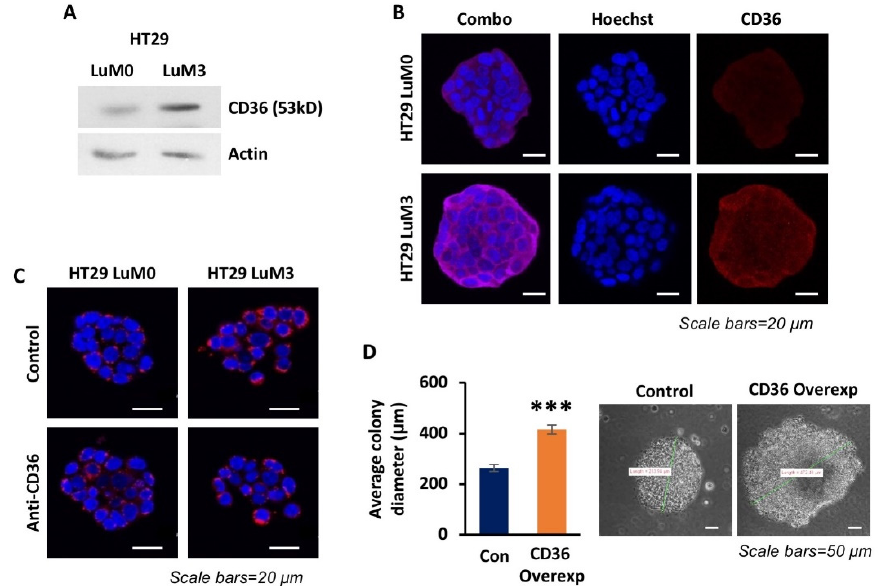
Figure 2. CD36 expression is associated with more metastatic CRC cell lines. ( A ) Western blot analysis of the HT29 LuM0 and LuM3 GFP-Luciferase cell lines. ( B ) Confocal microscopy images of HT29 LuM0 and LuM3 GFP-Luciferase cells for CD36 expression (red), nucleus (blue) and actin filaments (purple). ( C ) Confocal microscopy images of the HT29 LuM0 and LuM3 GFP-Luciferase fatty acid uptake assay control or treated with anti-CD36 blocking antibody for 24 h (lipid analogue—red; DAPI—blue). ( D ) Quantification and representative images of the HT29 LuM0 p-lenti-control and p-lenti-CD36 overexpression soft agar colony formation assays. N = 3, *** p < 0.001, SEM.